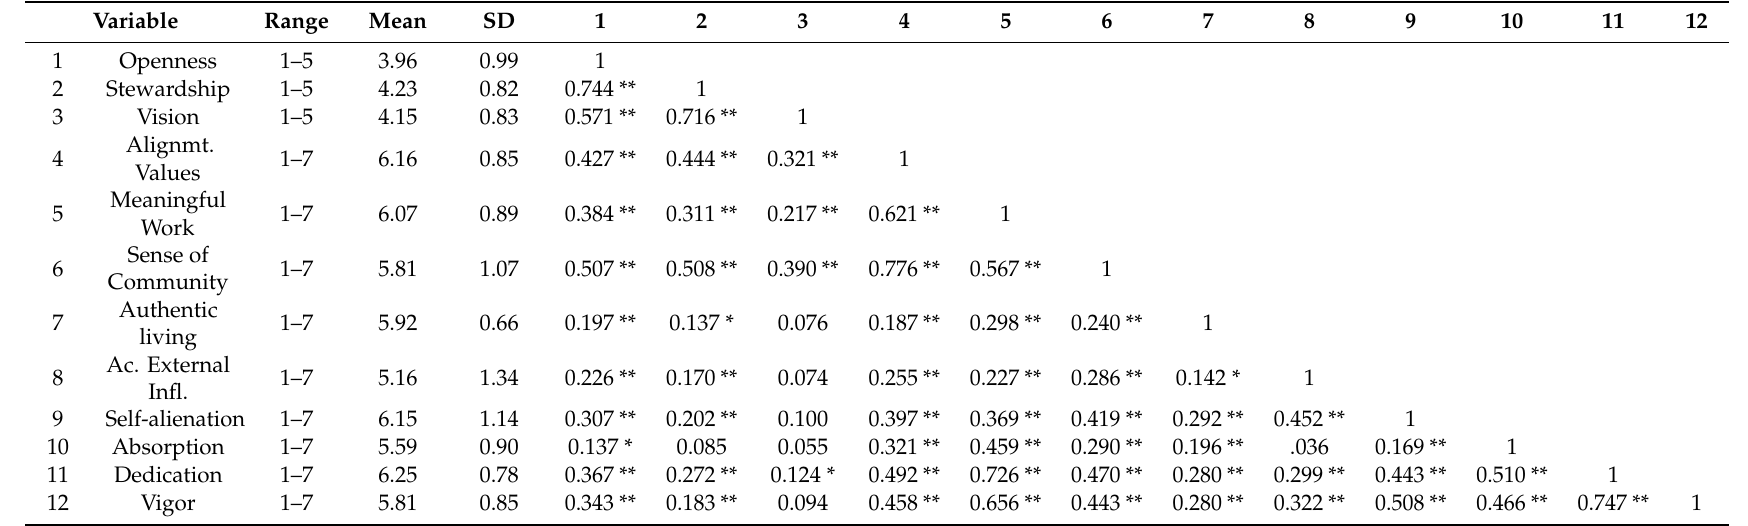
Table 1. Descriptive statistics and intercorrelations of the study